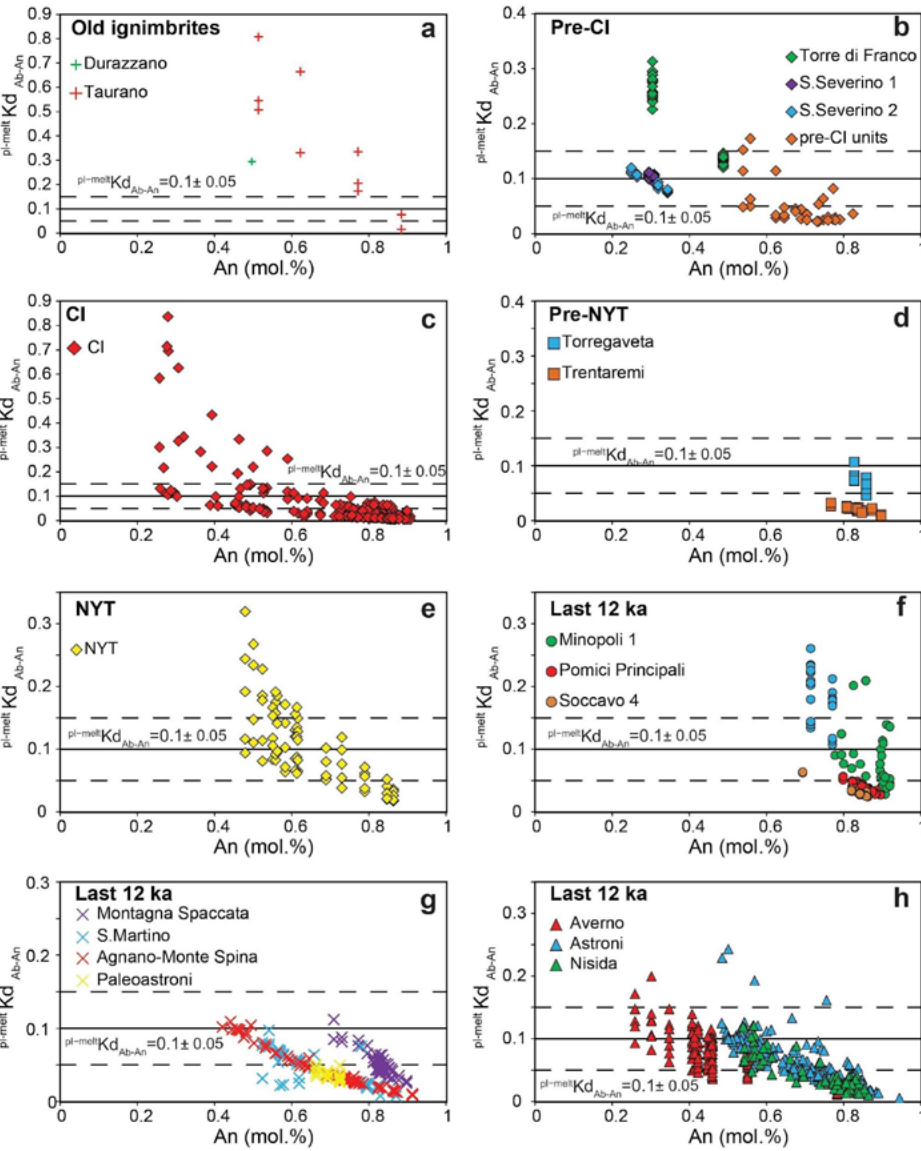
Figure 10. Equilibrium test 4: variation diagram of An (mol %) vs. calculated pl-melt Kd Ab-An , for Campi Flegrei plagioclases belonging to Old ignimbrites ( a ), Pre-CI ( b ), CI ( c ), Pre-NYT ( d ), NYT ( e ) and last 12 ka ( f – h ). The plagioclase-melt stability field was drawn using a value for pl-melt Kd Ab-An of 0.1 (continuous line) ± 0.05 (dotted lines; e.g., [13]).